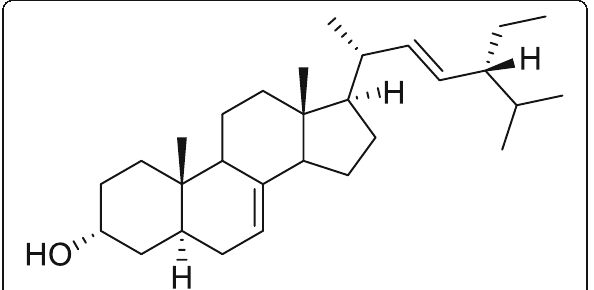
Fig. 3 Structure of Chondrillasterol. Data to elucidate the structure was obtained by NMR and MS